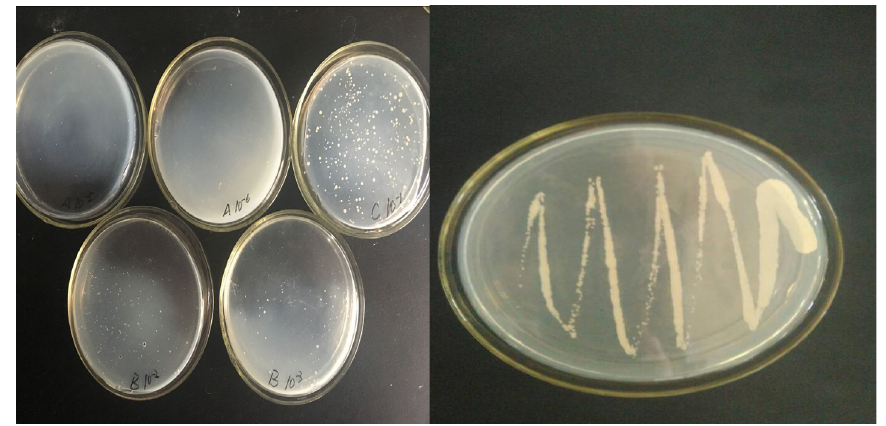
Figure 1: The preliminary result and conventional plate streaking of Strain C.